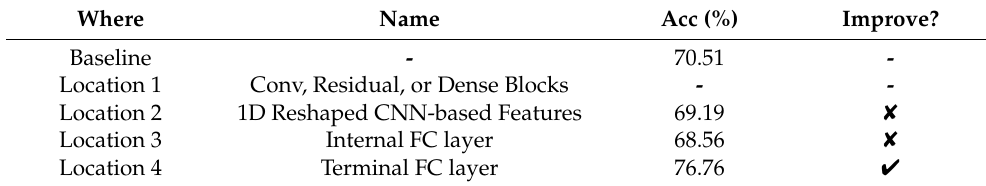
Table 11. Results of VGGNet + HOG at different injection locations on the OpenSARShip-1.0 dataset.